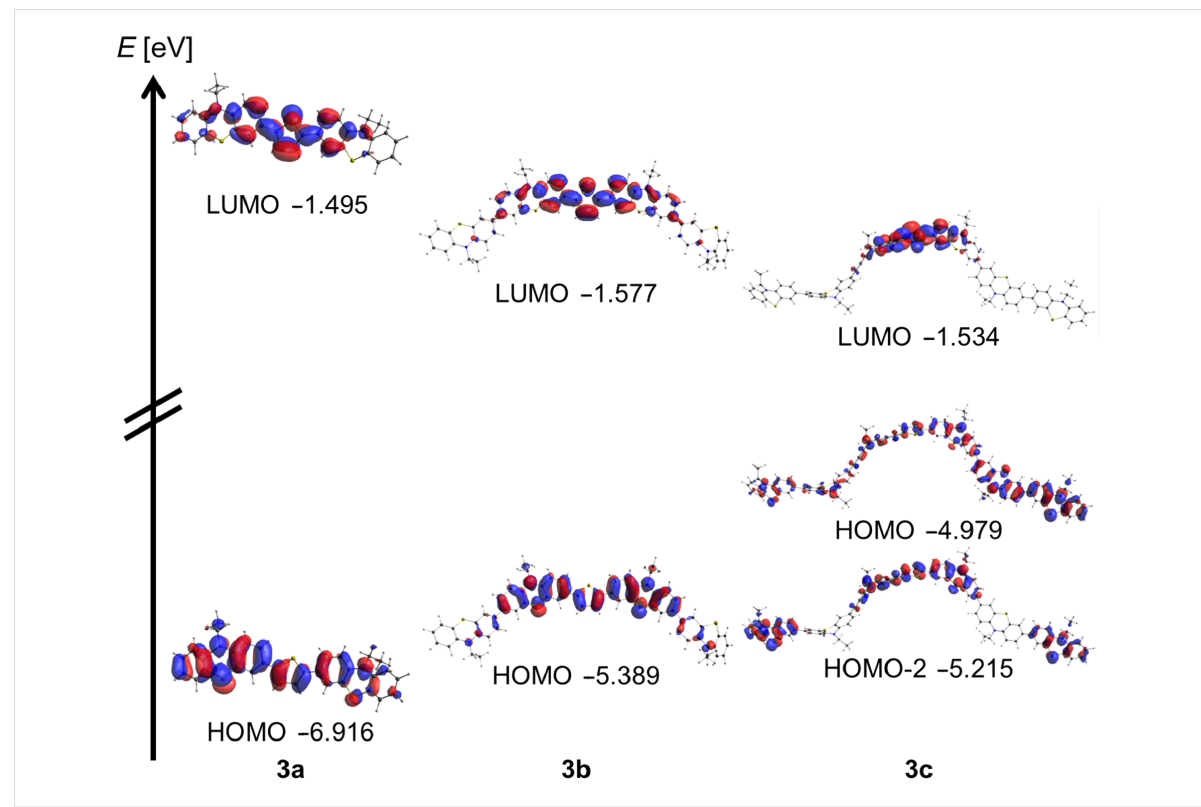
Figure 5: Relevant Kohn–Sham FMOs contributing to the S 1 states that are assigned to the longest wavelengths absorption bands of thienyl-bridged oligophenothiazines 3 (calculated with the B3LYP functional in vacuo and the 6-311G(d,p) basis set).